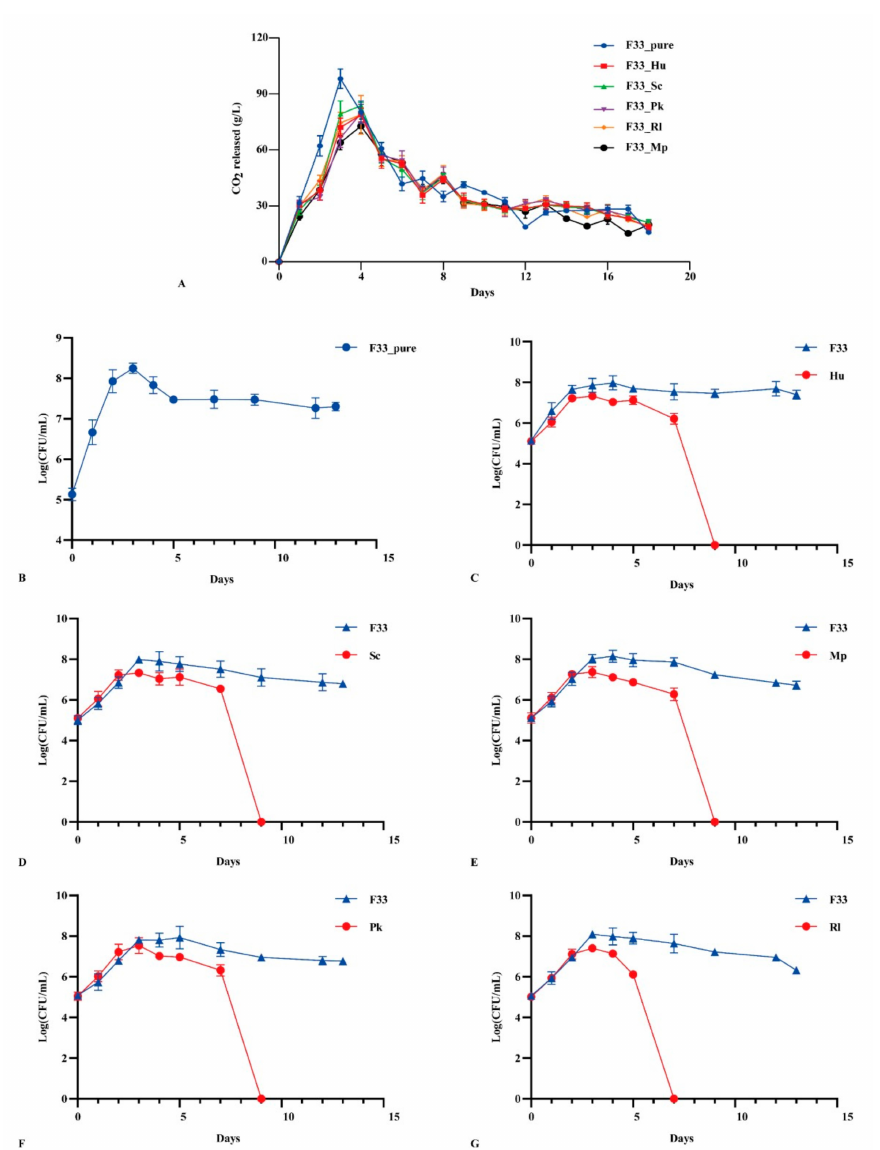
Figure 2. The fermentation kinetics characteristics and yeast population dynamics in Vidal icewine during fermentation with six fermentation strategies. ( A ) CO 2 release in pure and co-mixed fer- mentation. pure_F33: S. cerevisiae F33 monoculture. F33_Hu: co-inoculation of S. cerevisiae F33 and H. uvarum QTX22. F33_Sc: co-inoculation of S. cerevisiae F33 and S. crataegensis Y30. F33_Mp: co-inoculation of S. cerevisiae F33 and M. pulcherrima YC15. F33_Pk: co-inoculation of S. cerevisiae F33 and P. kluyveri HSP11. F33_Rl: co-inoculation of S. cerevisiae F33 and R. lusitaniae QTX26. ( B – G ) Yeast population dynamics in different fermentations. Hu: H. uvarum QTX22. Sc: S. crataegensis . Mp: M. pulcherrima YC15. Pk: P. kluyveri HSP11. Rl: R. lusitaniae